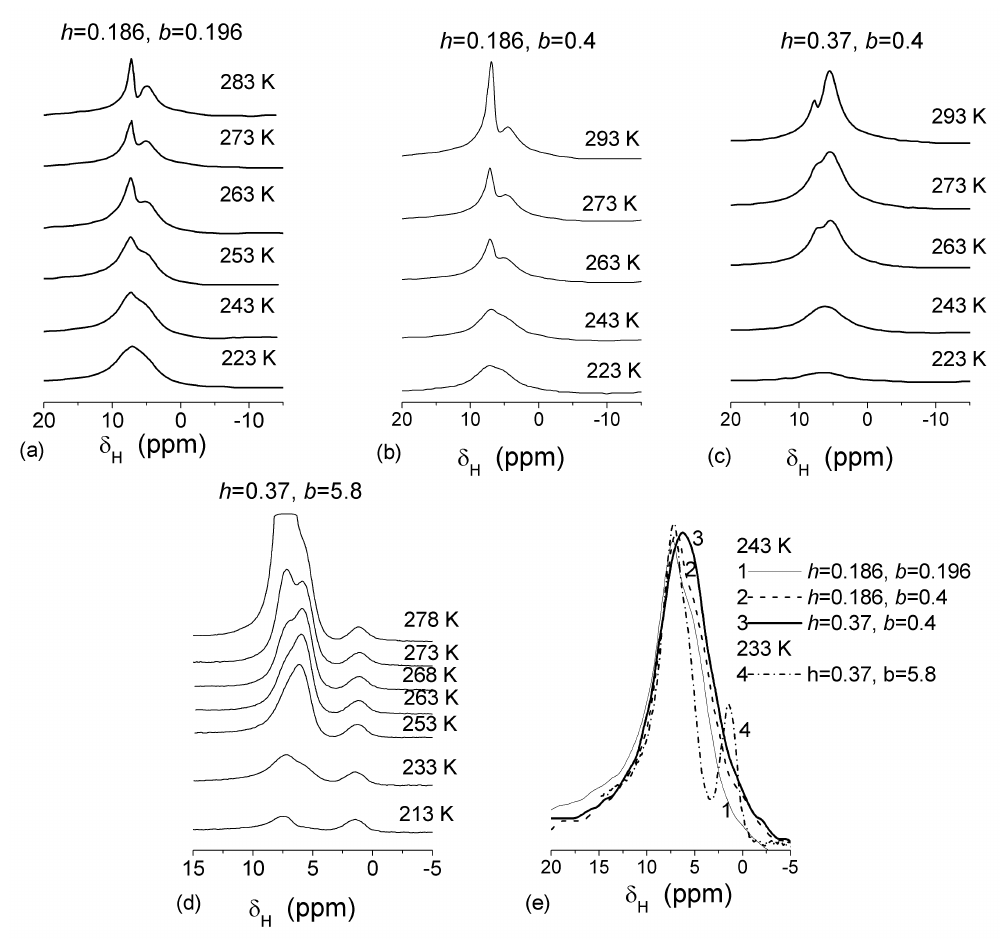
Fig. 10 1 H NMR spectra of water/benzene mixture adsorbed on MCM-41 at different temperatures and different amounts of water and benzene ( b ): h = (a, b, e) 0.186, (c, d, e) 0.37 ml/g and b = (a, e) 0.196, (b, c, e) 0.4 and (d, e) 5.8 ml/g (sample